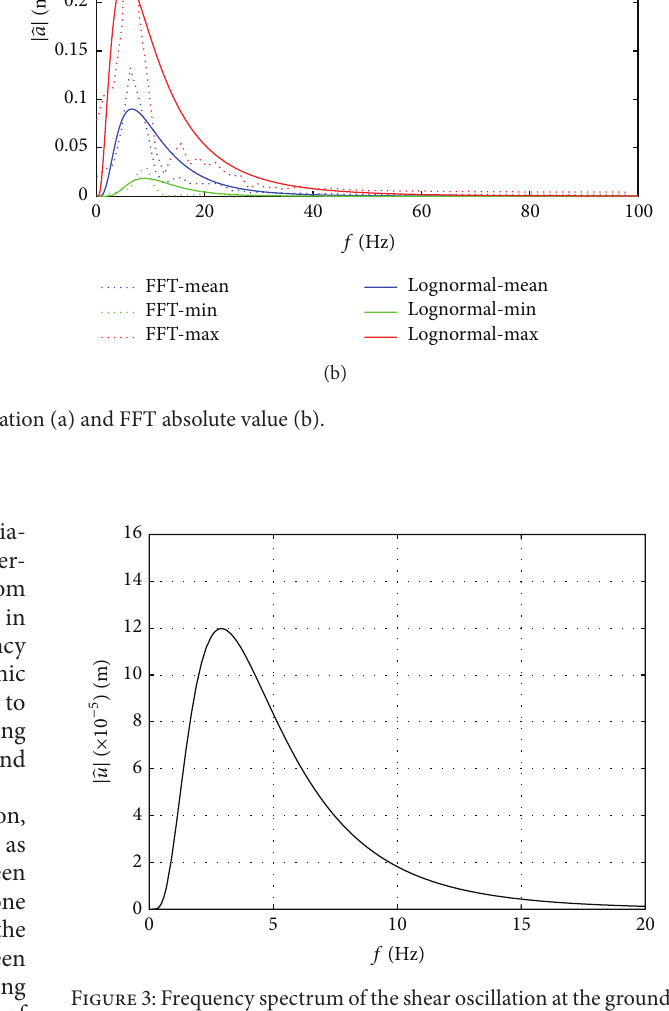
Figure 3: Frequency spectrum of the shear oscillation at the ground